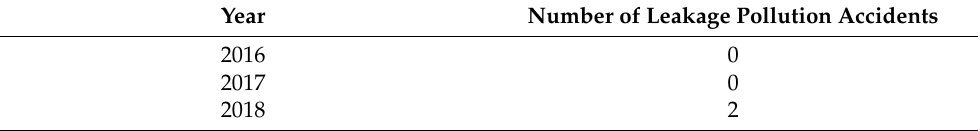
Table 12. Annual spill distribution table.